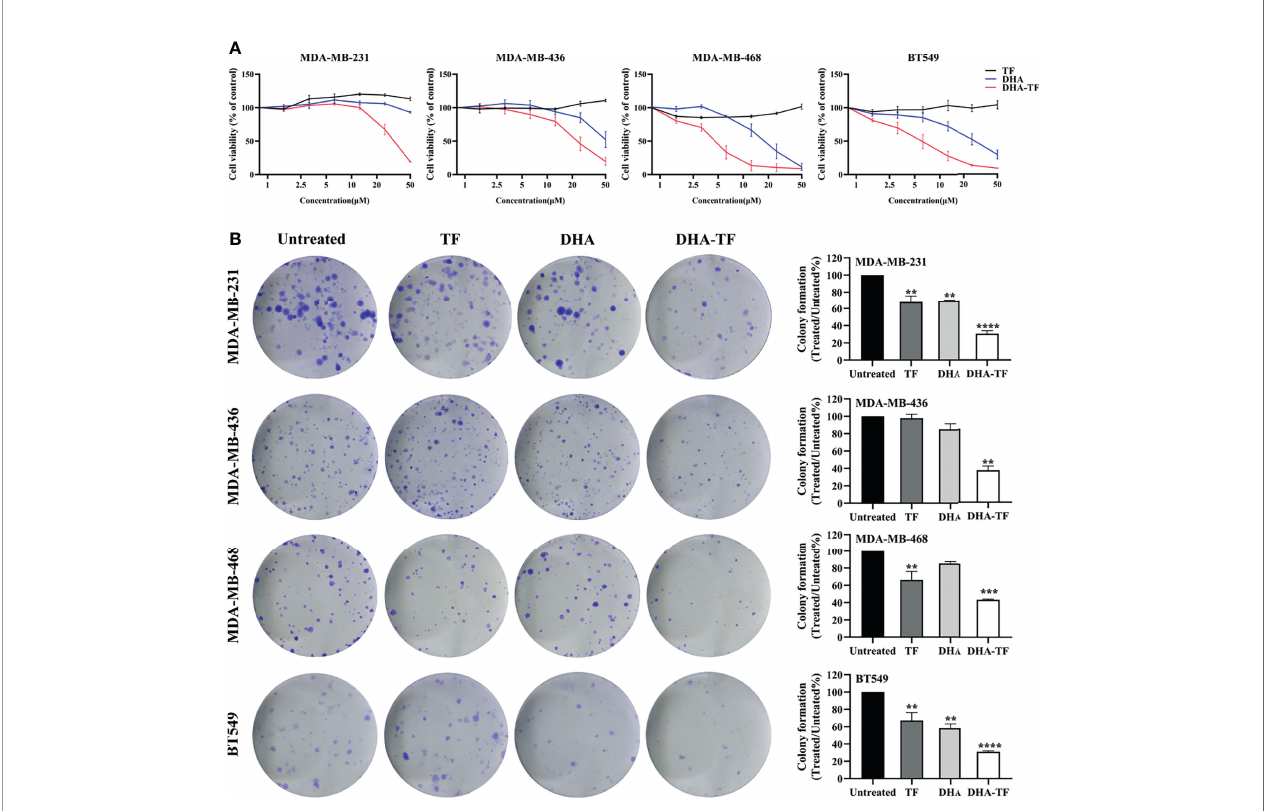
FIGURE 1 | DHA-TF adducts decrease cell viability compared with DHA in TNBC cell lines. (A) The sensitivity of MDA-MB-231, MDA-MB-436, MBA-MD-468, and BT549 to TF, DHA, or DHA-TF treatments. The cell viability was evaluated by MTS after cells had been exposed to different treatment options for 24 h. All the results were normalized to the untreated cells which is presented as 100% cell viability. (B) Clonogenic assay of DHA-TF for evaluation of long-term cell proliferation. TF, DHA, or DHA-TF was applied to MDA-MB-231 (15 µM), MDA-MB-436 (15 µM), MBA-MD-468 (5 µM), and BT549 (5 µM). Representative images are shown in the left panel, and the quanti fi cation of three independent experiments are shown in the right panel as bar graphs. Cells were stained and viable colonies were normalized to the number of colonies in untreated cells. Data shown are mean ± SEM from three independent experiments performed in triplicate. **0.001 < p ≤ 0.01, ***0.0001 < p ≤ 0.001, ****p ≤